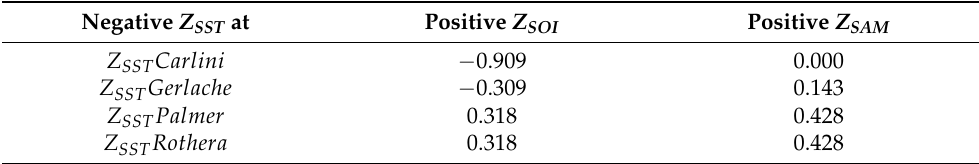
Table 7. Values for the relative power index, Pr index , evaluating the coincidence of high Southern Oscillation Index (SOI) or Southern Annular Mode (SAM) conditions with low temperatures at each station.